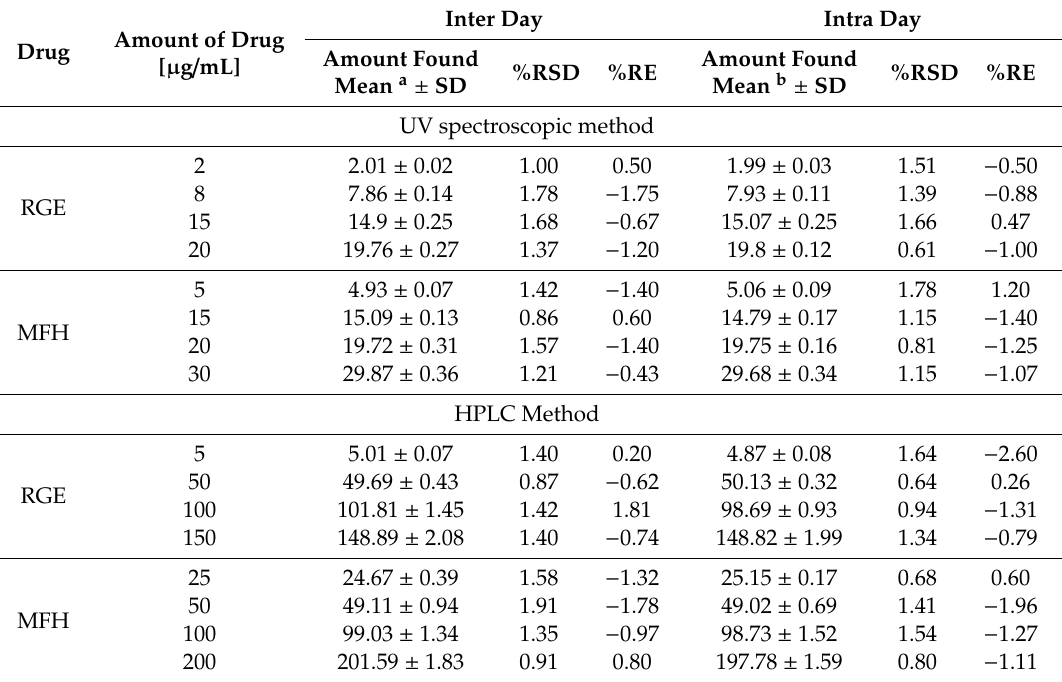
Table 4. Precision and accuracy results of MFH and RGE by the proposed methods.